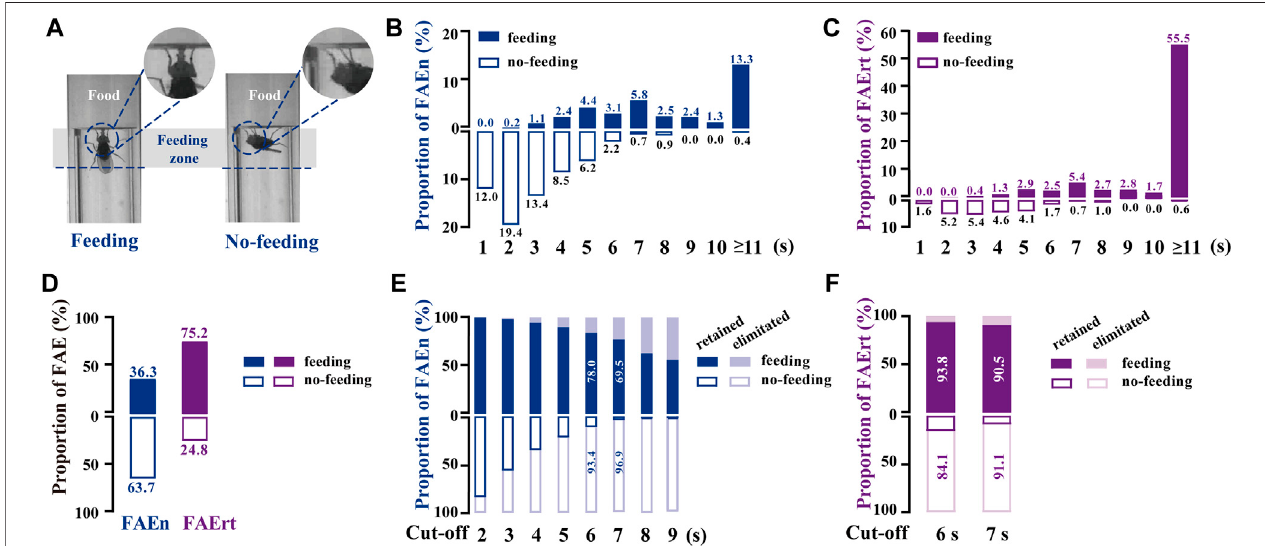
FIGURE 2 | Analyzing food-approaching behavior using high-magni fi cation recording (A) Two video snapshot images showing FAE under feeding (left) and no- feedingconditions (right)(B) ProportionaldistributionofFAEn.Thenumbersoneachcolumnindicatethepercentageoftheeventnumberswithorwithoutfeedinginthe total event number (551) (C) Proportionaldistribution ofFAErt. The numbers on each column indicate the percentage of theresidence time with or without feedingin the total residence time (4,132 s) (D) The proportion of total feeding and no-feedingevents (FAEn) and time(FAErt) (E) As the cut-off threshold increasesfrom 2 to 9 s, the ratio of retained feeding events to all feeding events (200) gradually decreases, while the ratio of retained no-feeding events to all no-feeding events (351) decreases rapidly (F) The proportion of retained FAErt with the cut-off threshold set to either 6 or 7 s.